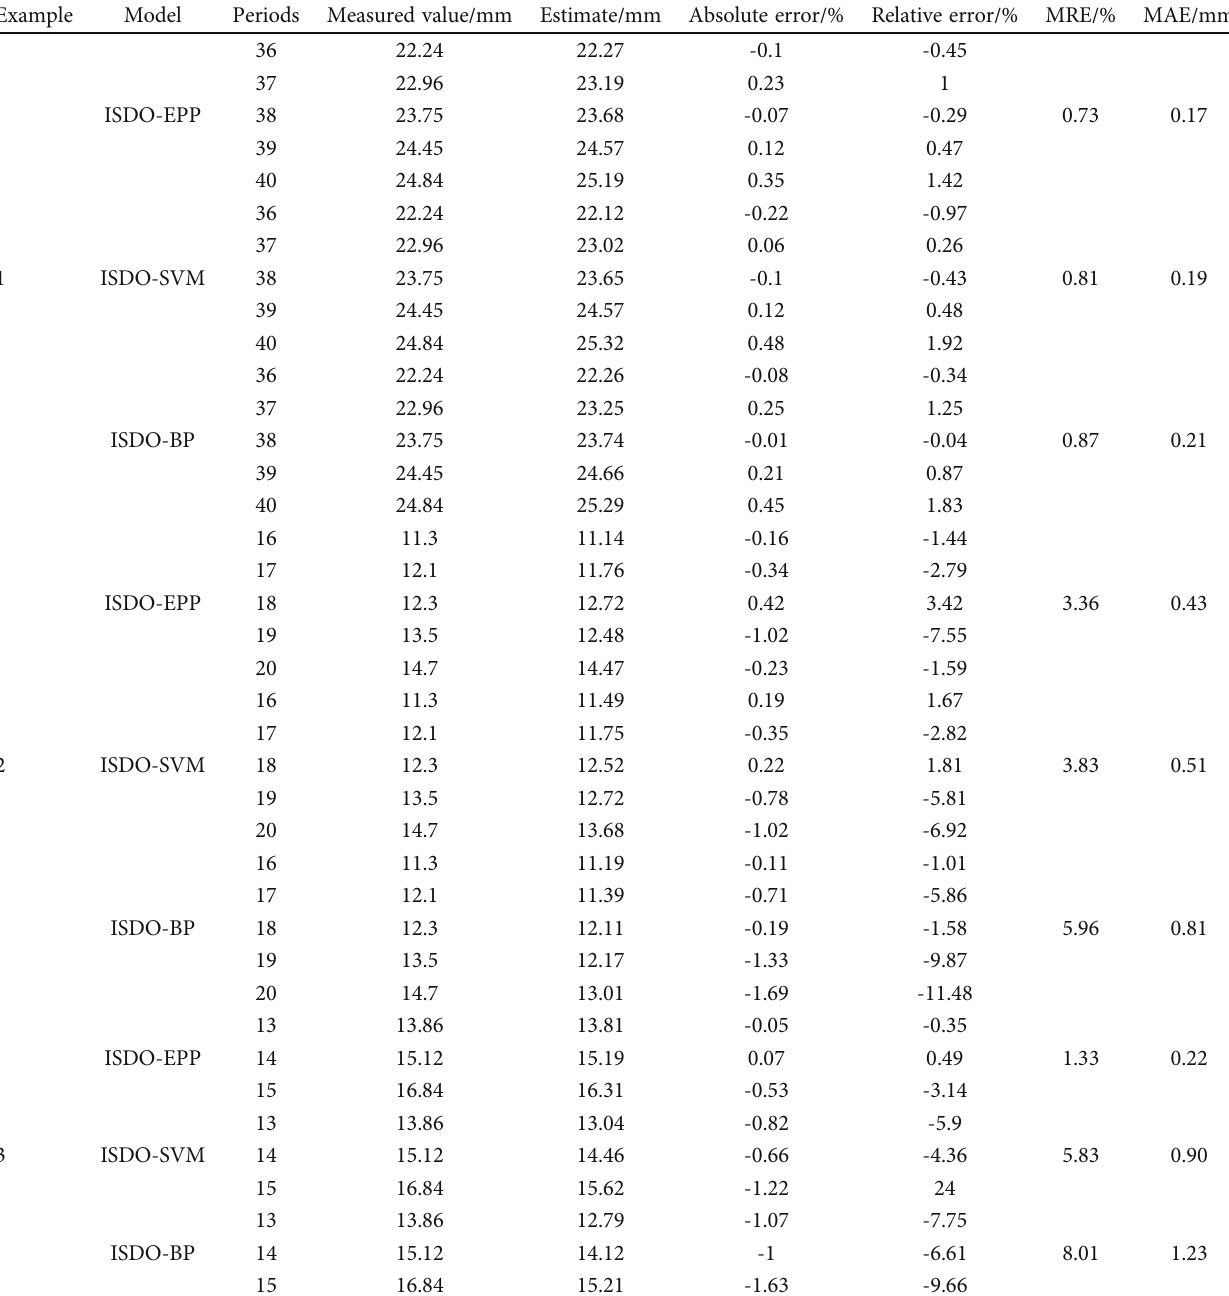
Table 3: Comparison of deformation prediction models of each foundation